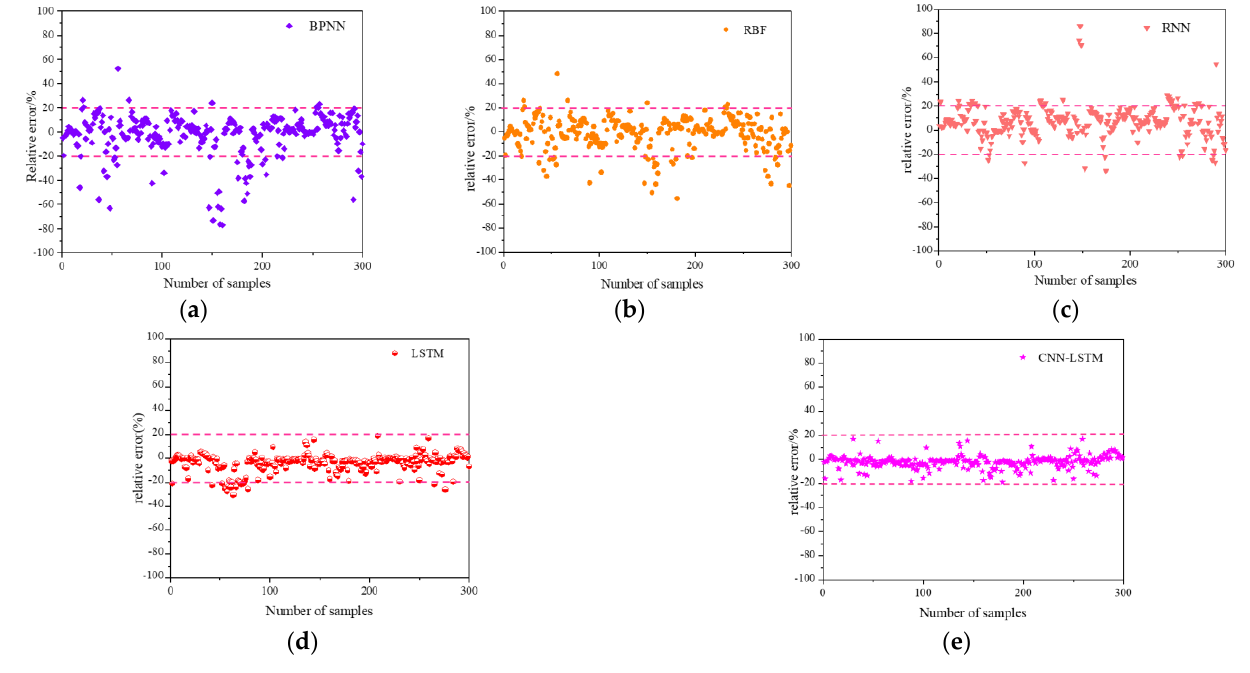
Figure 11. Relative error of five models.